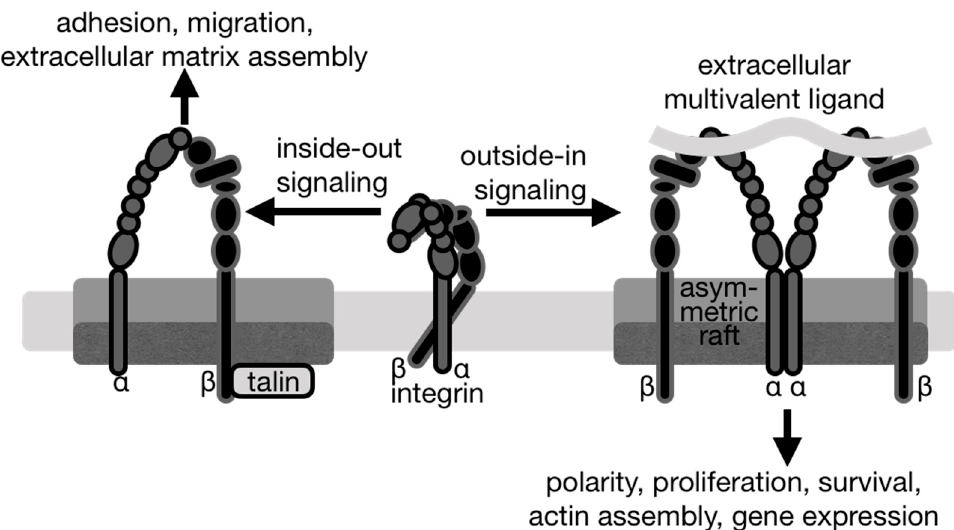
Figure 4. Integrins signal in both directions with different outcomes. Left, inside-out integrin signaling is initiated by the binding of an intracellular activator such as talin or kindlin to the integrin β cytoplasmic tail domain. This leads to conformational changes that activate integrins by increasing the integrin affinity for extracellular ligands. The resulting strong interactions between integrins and the extracellular matrix enable integrins to transmit forces for extracellular matrix remodeling and assembly as well as cell migration. Center , in its inactive, low-affinity state, the integrin is in a bent conformation. Right, during traditional outside-in signaling, multivalent extracellular ligands bind to integrins, thereby causing a conformational change and integrin clustering.